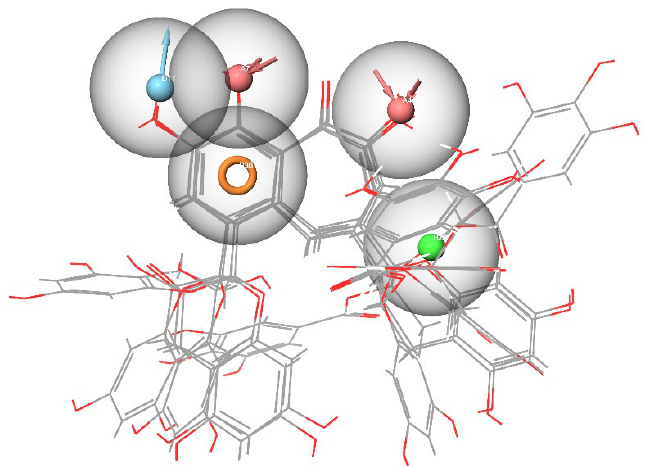
Figure 5. Pharmacophore model of the RBD site b of a spike protein generated by the Receptor cavity method.